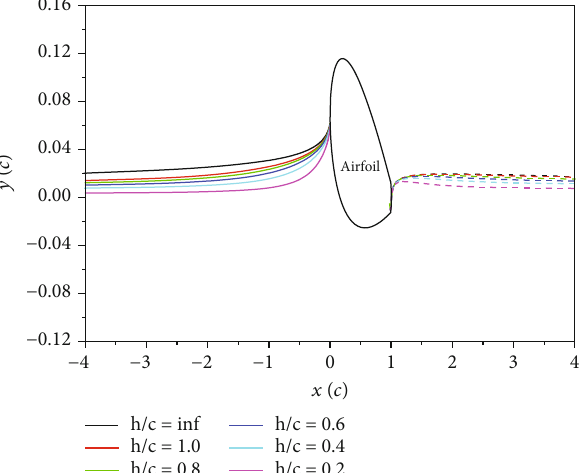
Figure 24: Pressure coe ffi cient of the CC airfoil for blowing with C pressure coe ffi cient of the Coanda surface.